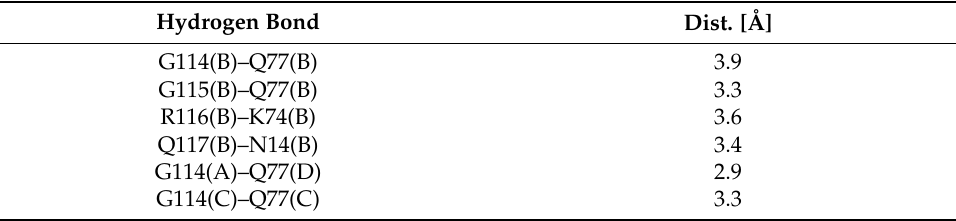
Table 4. The formation of hydrogen bonds at the GGRQ motif in